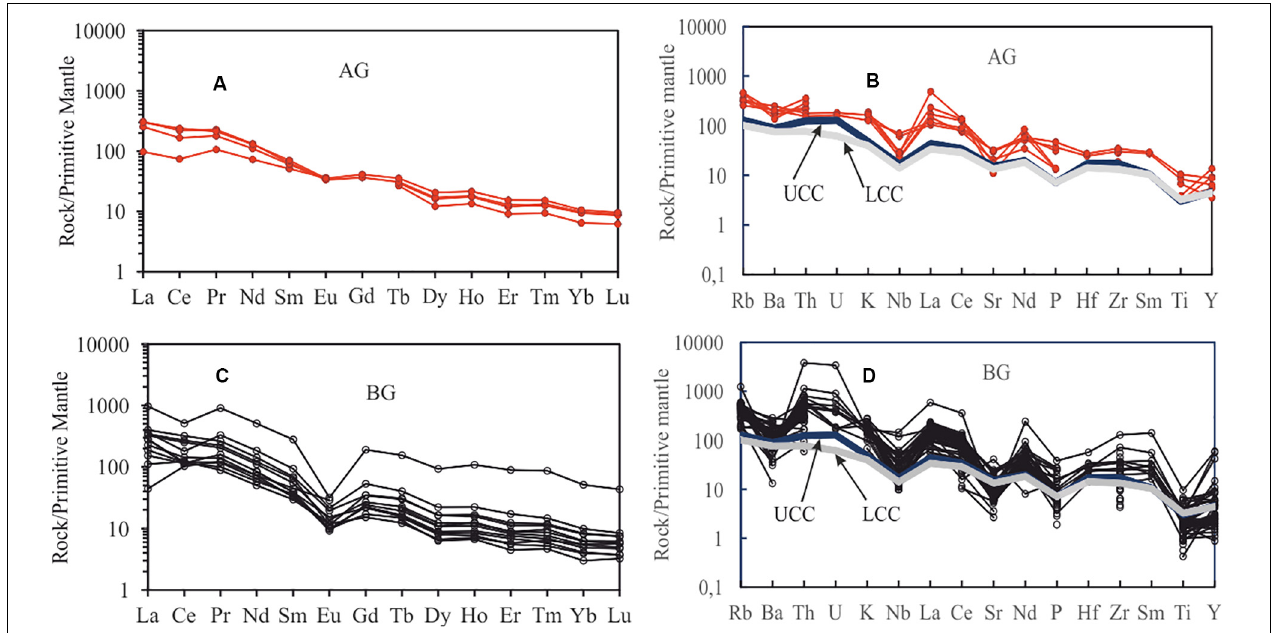
FIGURE 6 | Primitive mantle-normalized REE patterns (A,C) and primitive mantle-normalized spidergrams (B,D) . Normalizing values are from Sun (1982) and McDonough et al. (1992) (AG, amphibole granite; BG, biotite granite; UCC, upper continental crust; LCC, lower continental crust after Rudnick and Gao, 2003).